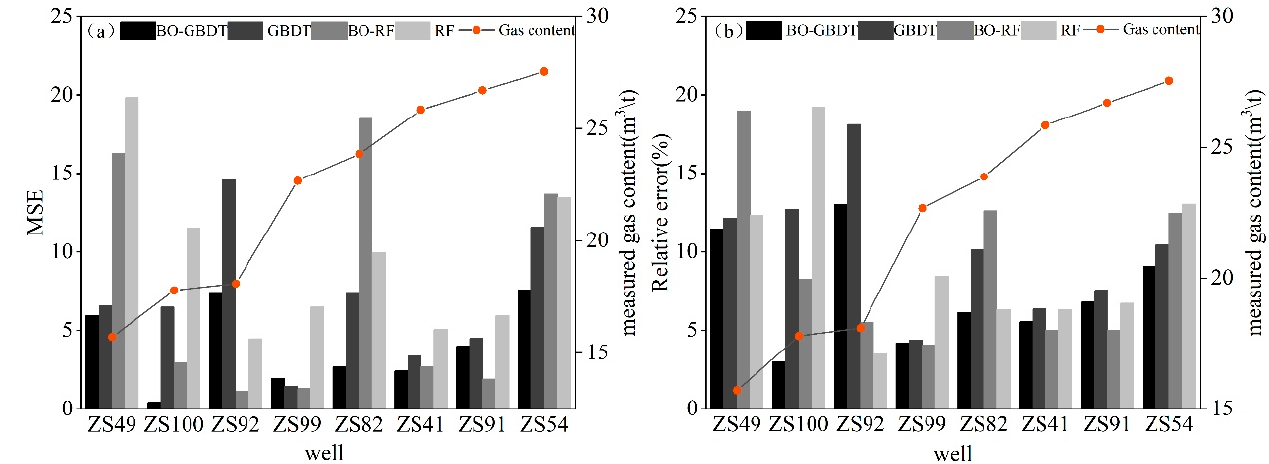
Figure 10. Comparison of prediction results of test wells:( a ) MSE; ( b ) relative error.